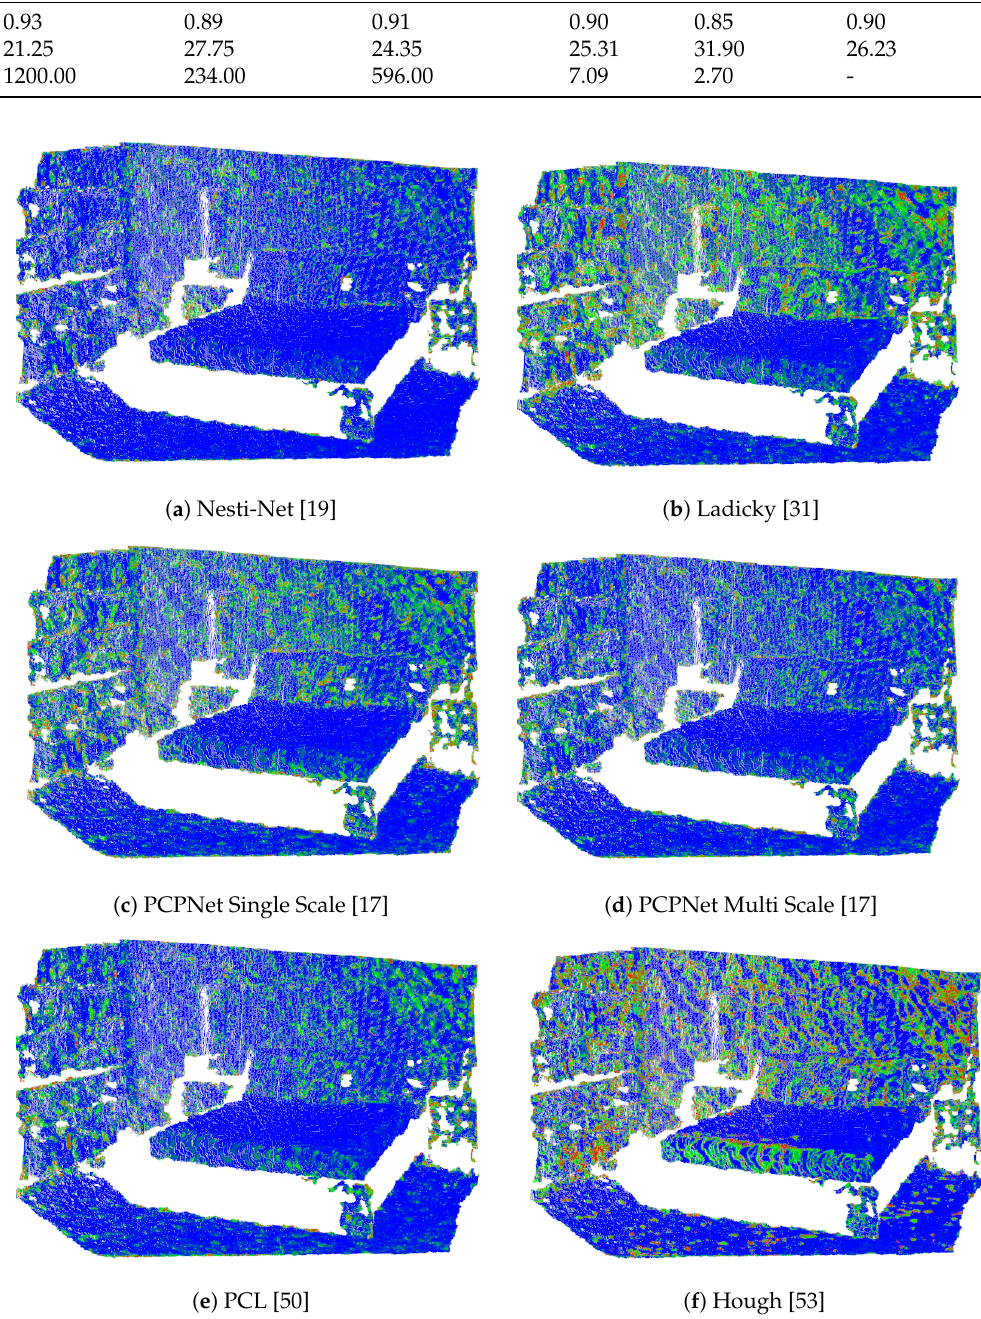
Figure 6. Comparison of the output of the methods on the same